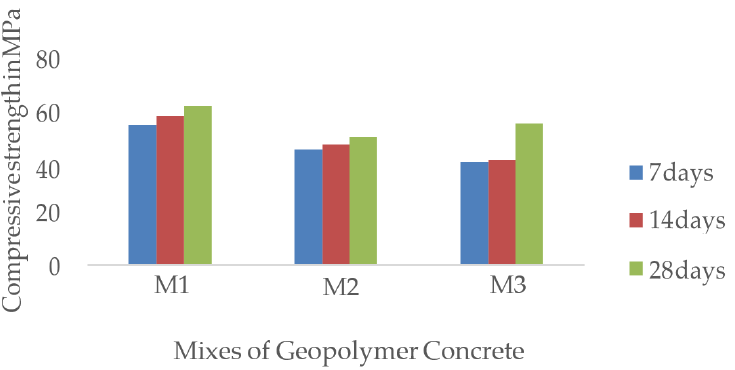
Figure 6. Compressive strength of geopolymer concrete with different mixture compositions [131].